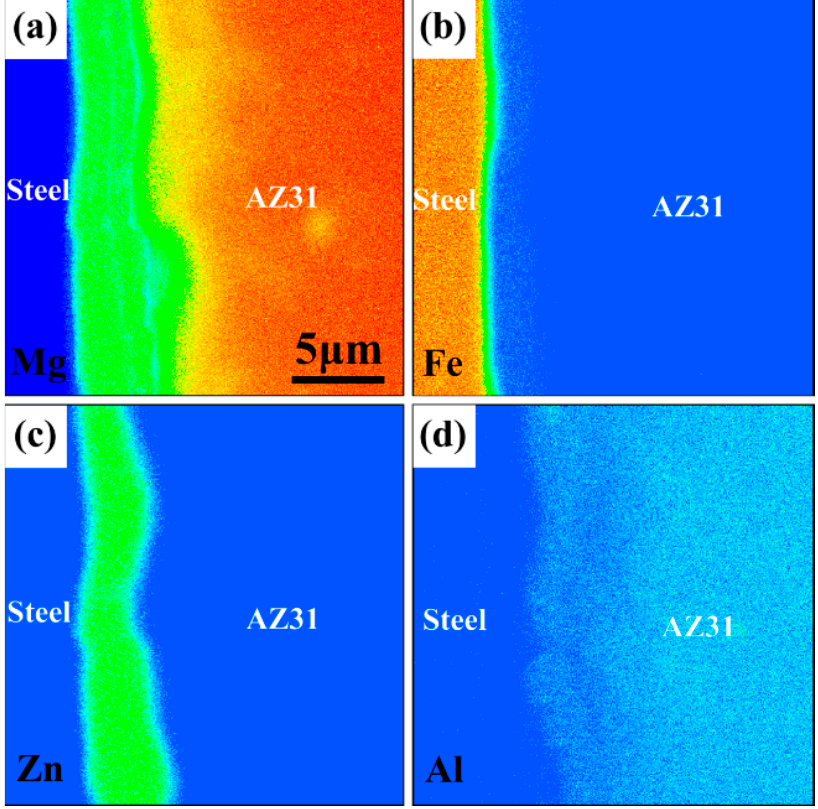
Figure 4. Map analysis of the interface: ( a ) Mg, ( b ) Fe, ( c ) Zn, and ( d ) Al. The roll-clad composite sheet was peeled to investigate the bonding characteristics.